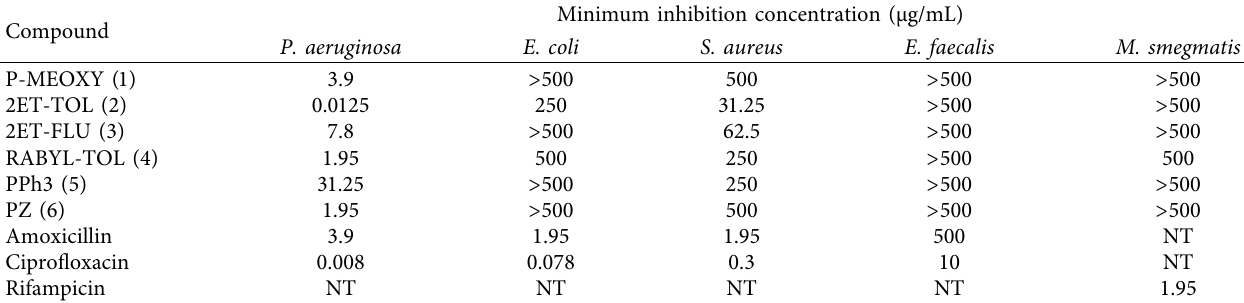
Table 1: Antimicrobial activity of synthesized